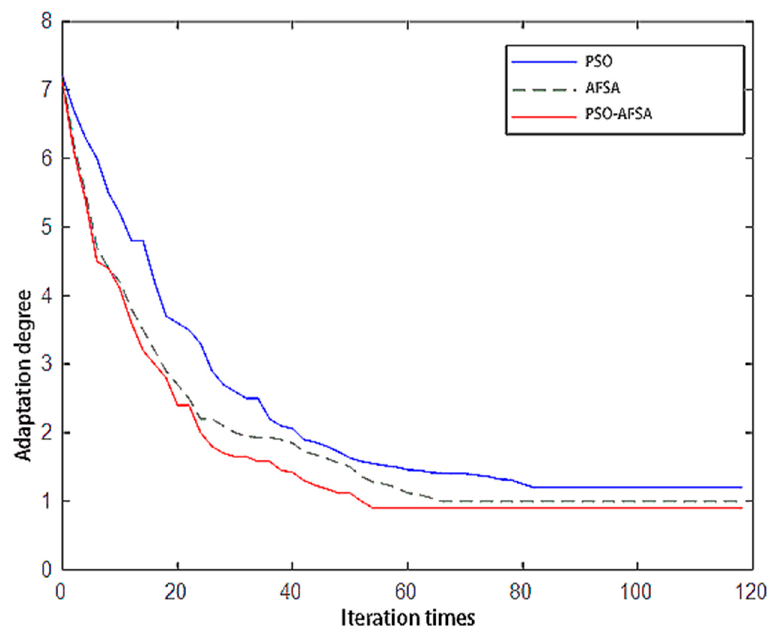
Figure 8. Comparison of the optimization iterations of the three algorithms. After 57 iterations of PSO–AFSA, the optimal node sequence is [ 0.21, 0.15, 0.18, 0.17, 0.15, 0.19 ] , and the total time is 1.05 s. Compared with those of PSO and AFSA, the optimal time is increased by 30.48% and 12.38%, respectively. Compared with the other two algorithms, it is easier to eliminate the defect of falling into a local